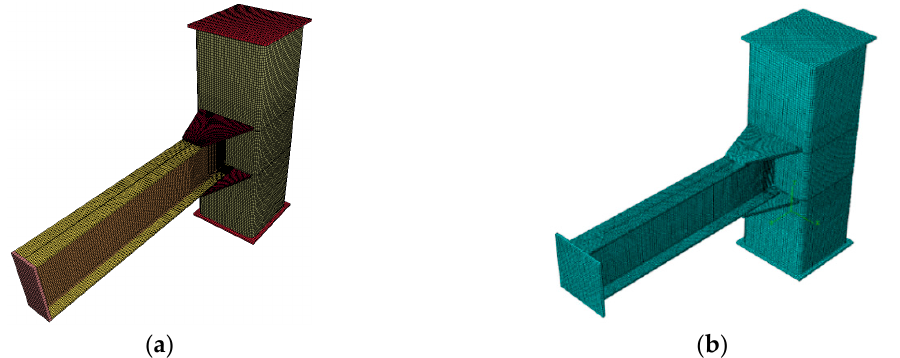
Figure 10. Finite element models of plate-reinforced large CFT connection. ( a ) LS-DYNA model; ( b ) ABAQUS model.